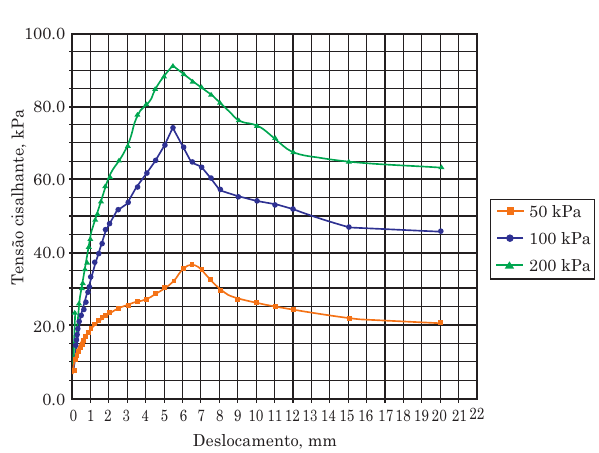
Figura 3. Tensão cisalhante vs deslocamento horizontal para as amostra do talude sem cobertura do capim vetiver.